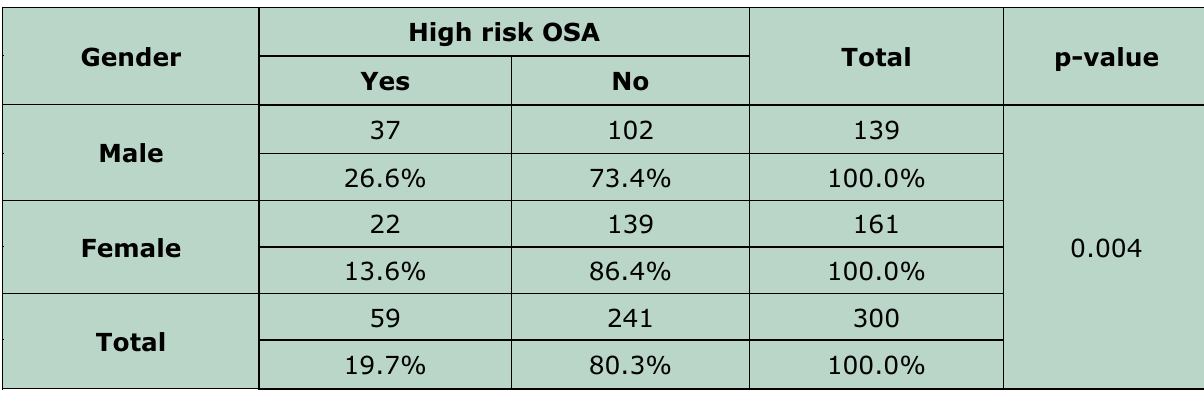
Table-III: Stratification of High risk OSA with respect to Gender.